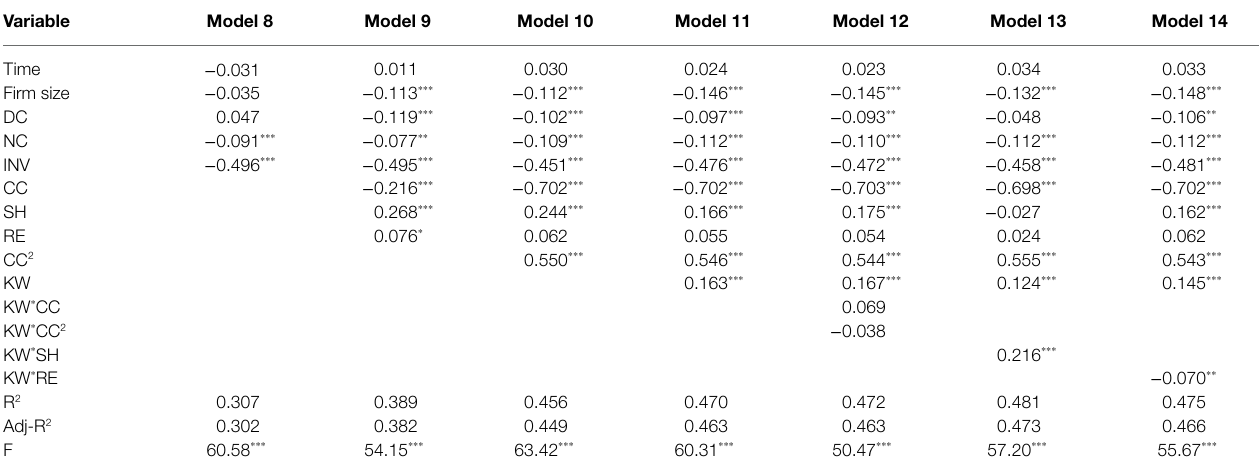
TABLE 4 | Robustness